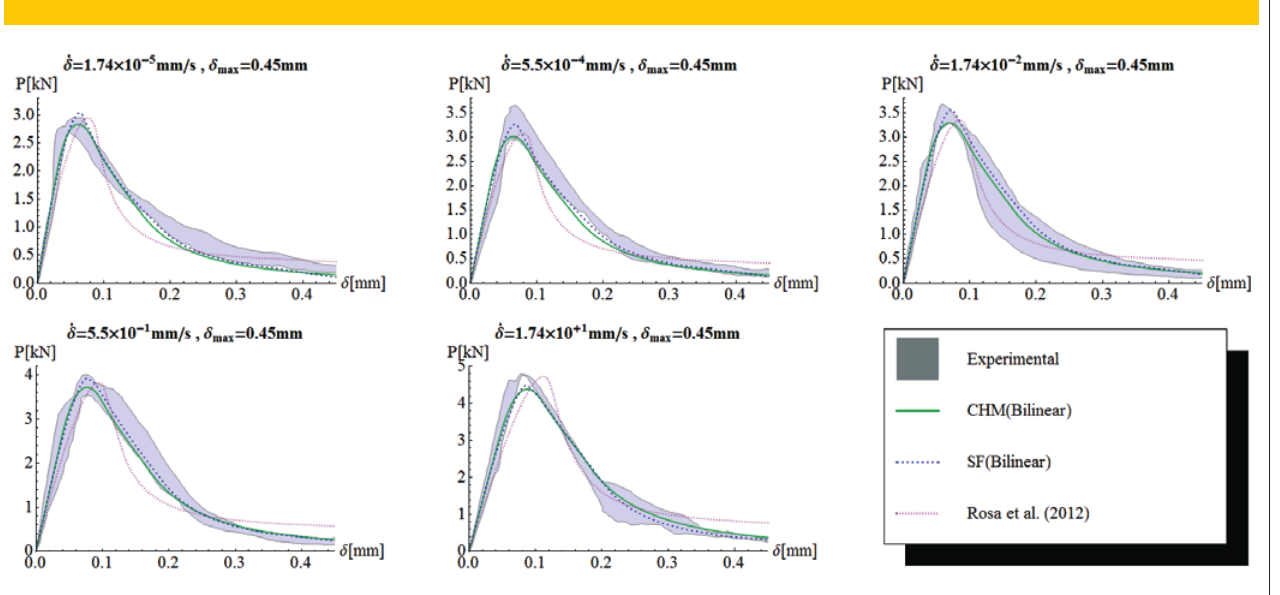
curves for the range of 0 to 0.45 mm of simultaneously fit P- d of bilinear and viscous